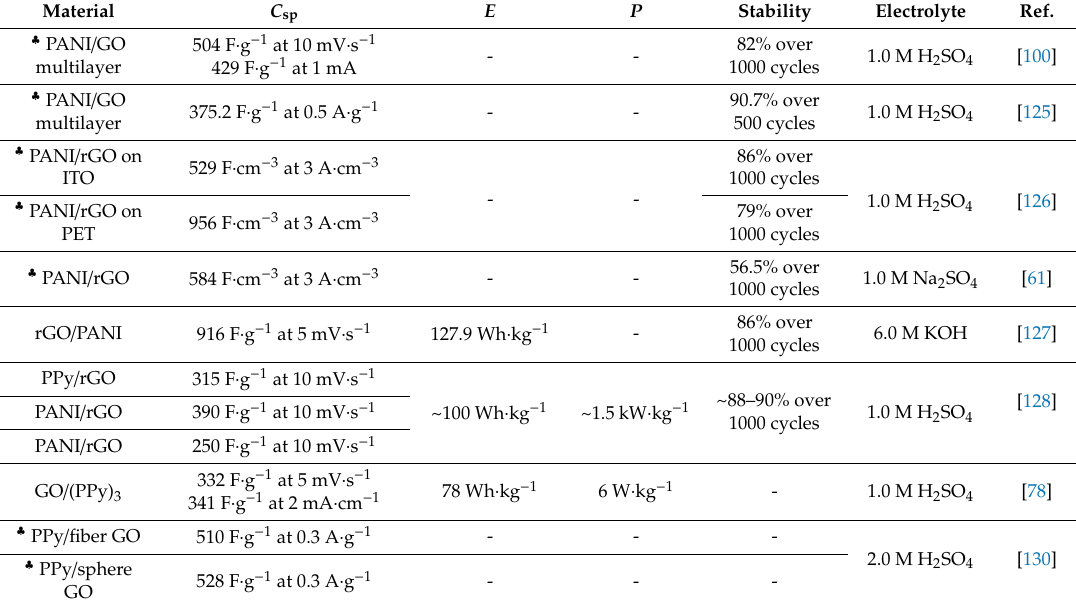
Table 2. Conducting polymer-carbon material based layer-by-layer